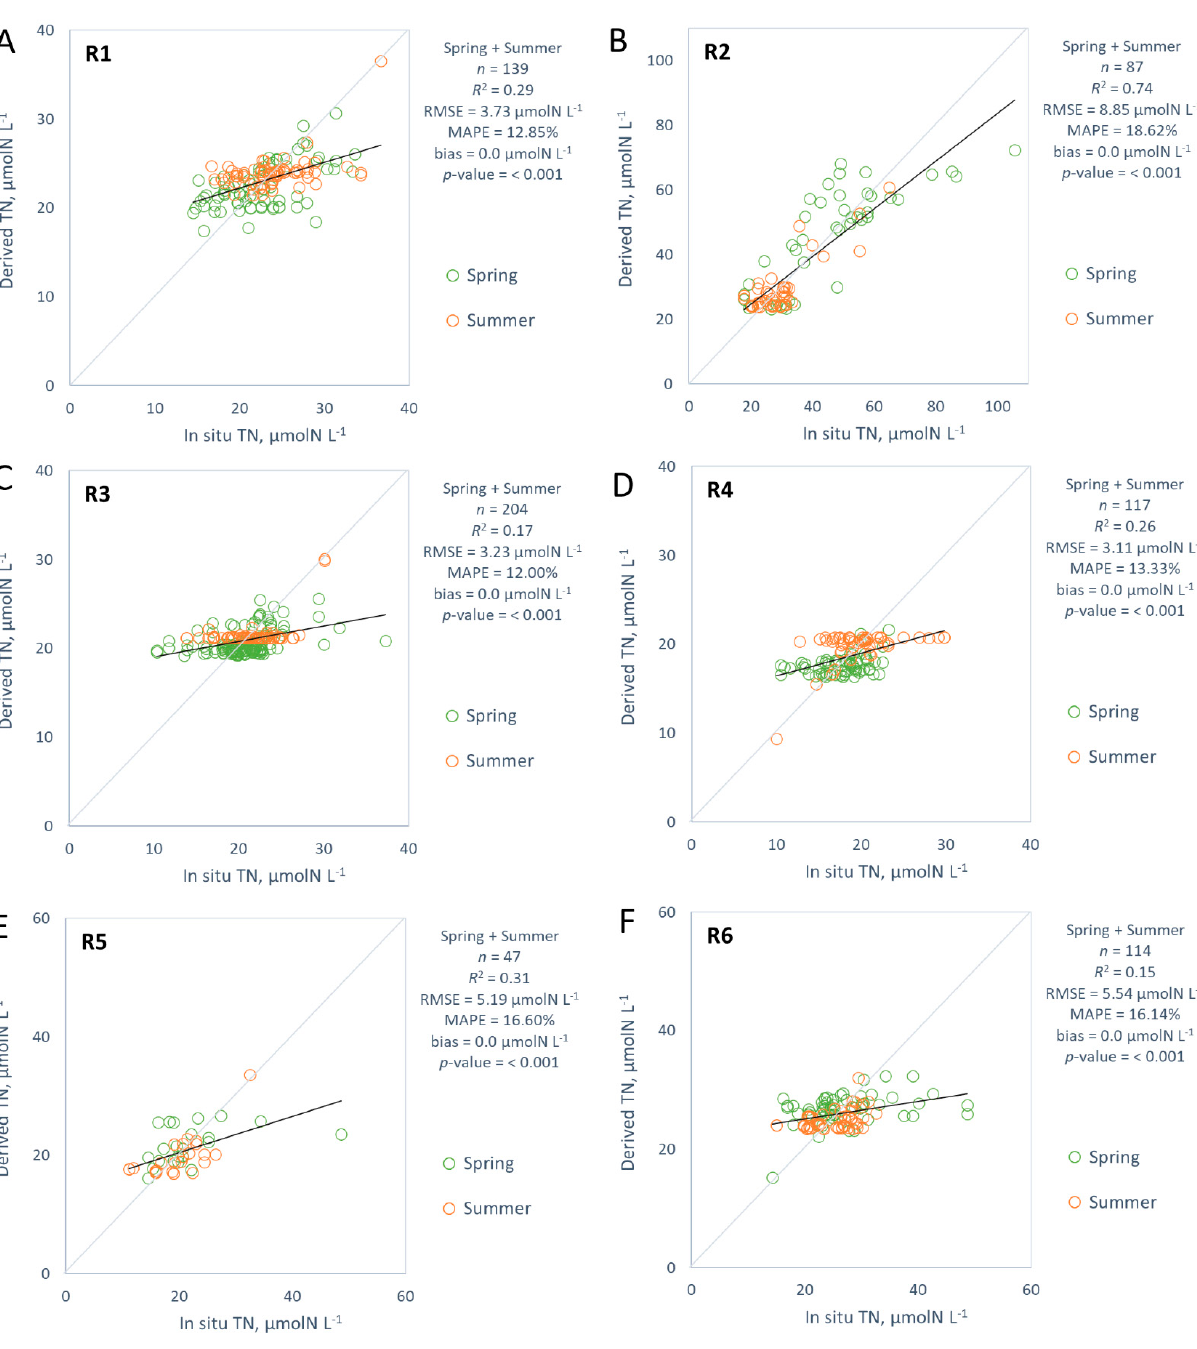
Figure 5. The comparison of the derived total nitrogen (TN, µ molN L − 1 ) with in situ TN in each region of Estonian marine waters ( A – F ). The statistics on the right and the linear regression trendline (black line) are combined periods of spring (April to June: green rings) and summer (July to September: orange